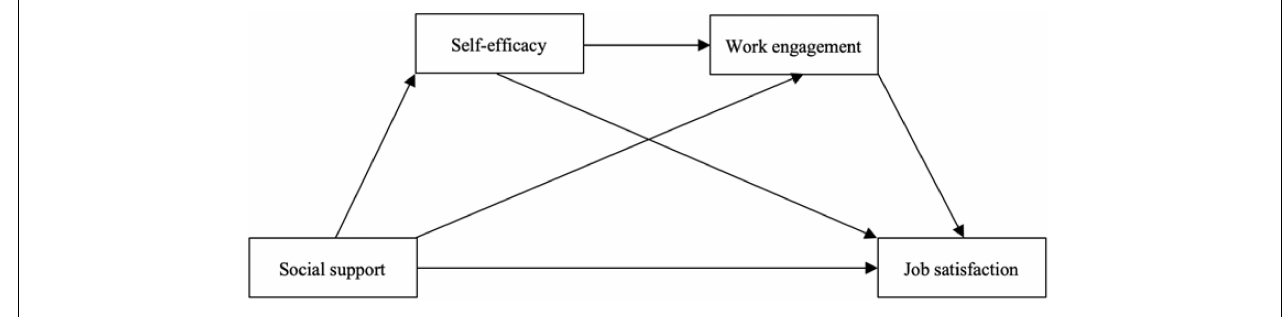
FIGURE 1 | The posited model.